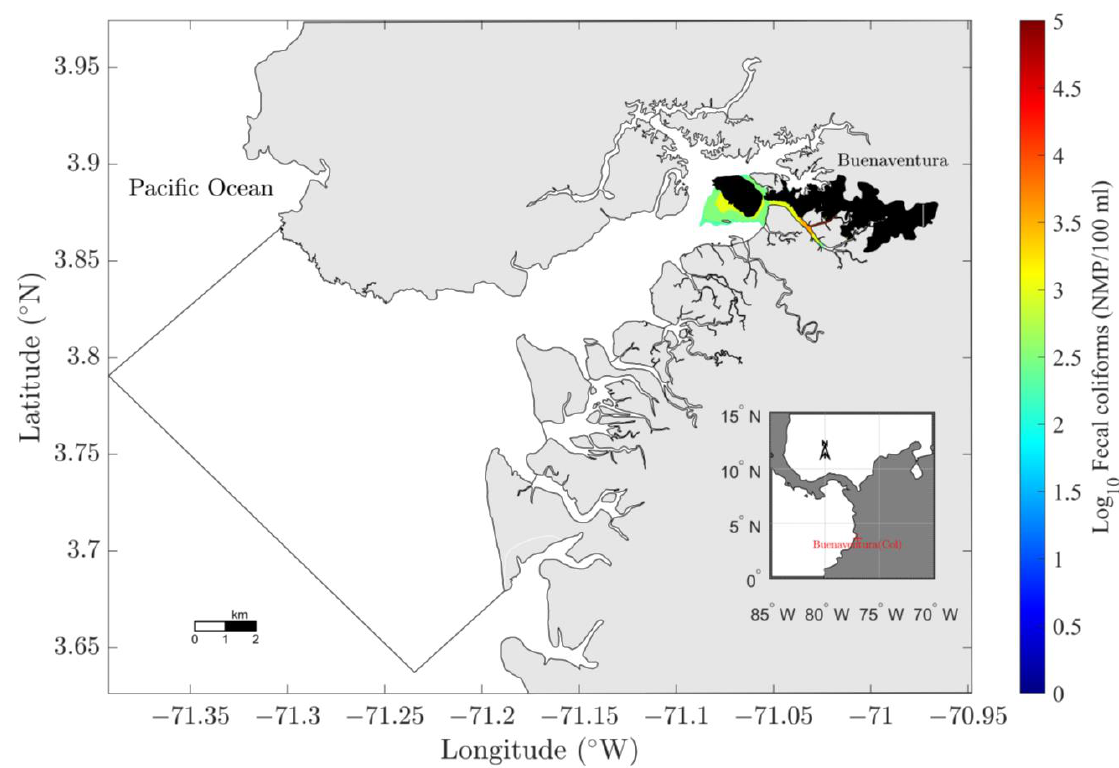
Figure 15. Spatial distribution of the maximum fecal coliform concentration in Buenaventura Bay in scenario four. scenario